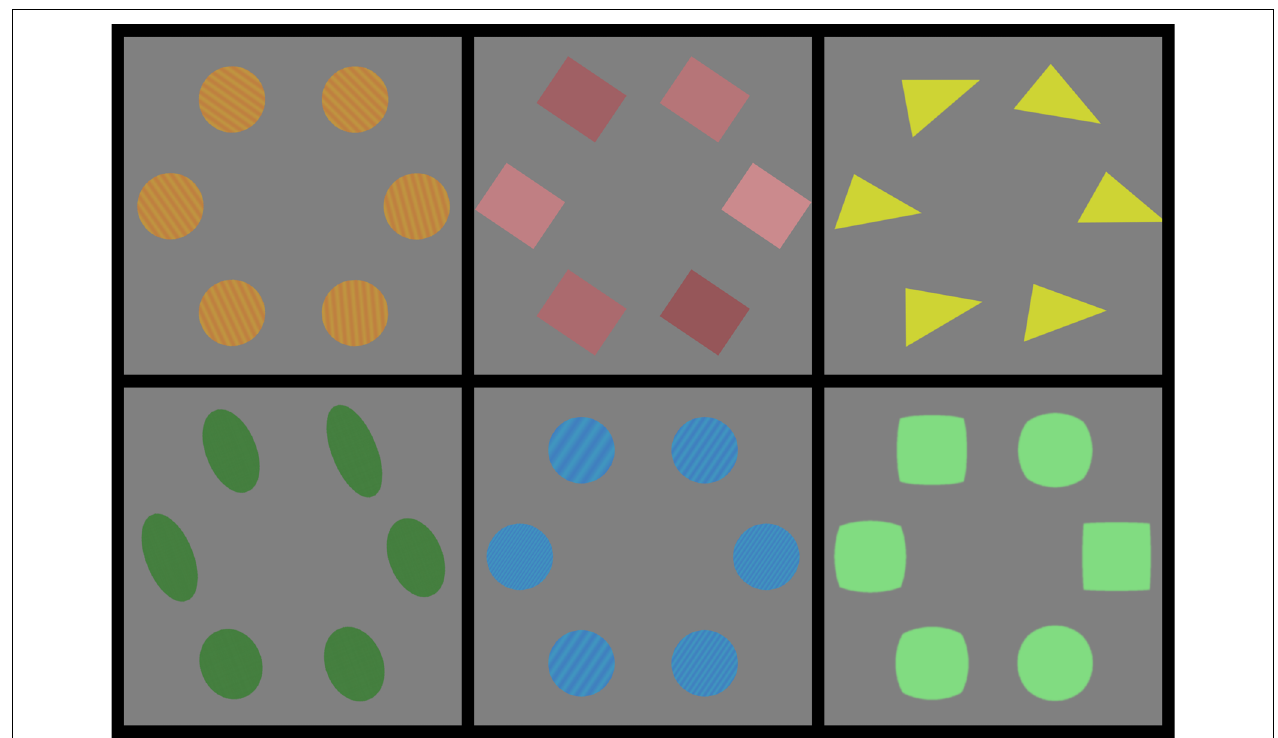
FIGURE 1 | Sample stimuli. Clockwise from top left: linetilt; luminance; orientation; shape; spatial frequency; proportion.